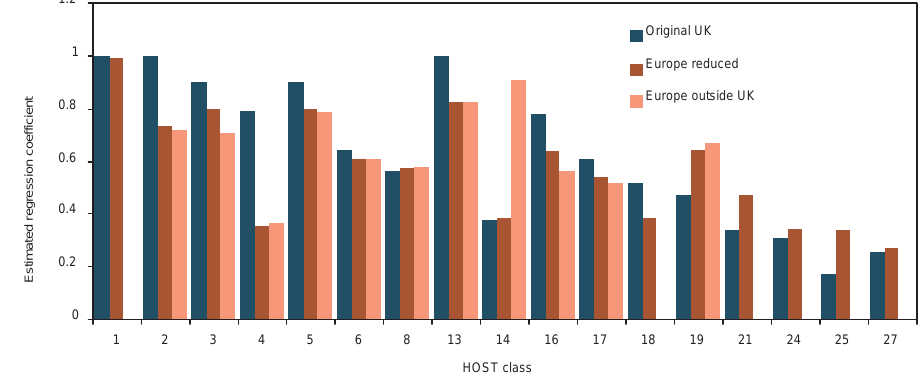
Fig. 5. Comparison of estimated regression coefficients per HOST class from the original UK study and from European catchments inside and outside the UK based on the reclassified SGDBE. Original UK designates the coefficients obtained by Boorman et al. (1995: Table 3.8). Europe reduced are the estimates for the reduced set of catchments from the UK and Europe (Groups C + D; rhomboids and circles in Figs. 3 and 4), constraint to lay between 0 and 1 and optimised using step-wise Akaike. Europe outside UK designates the values estimated from catchments outside the UK only (Group D; circles in Figs. 3 and 4), using constraints 0 and 1 and step-wise optimisation. Only those classes are shown for which coefficients from the Europe reduced dataset could be